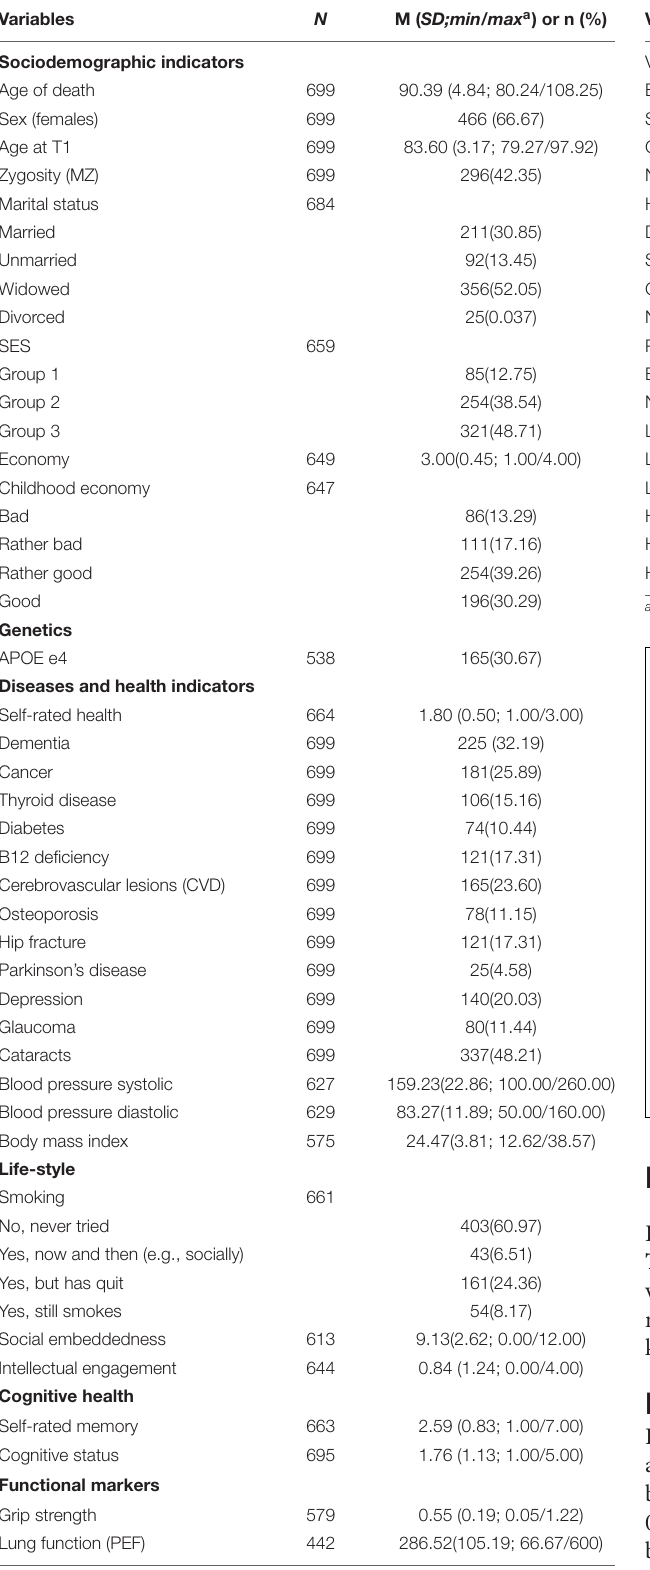
TABLE 1 | Descriptive for the OCTO-Twin sample used in the analyses.